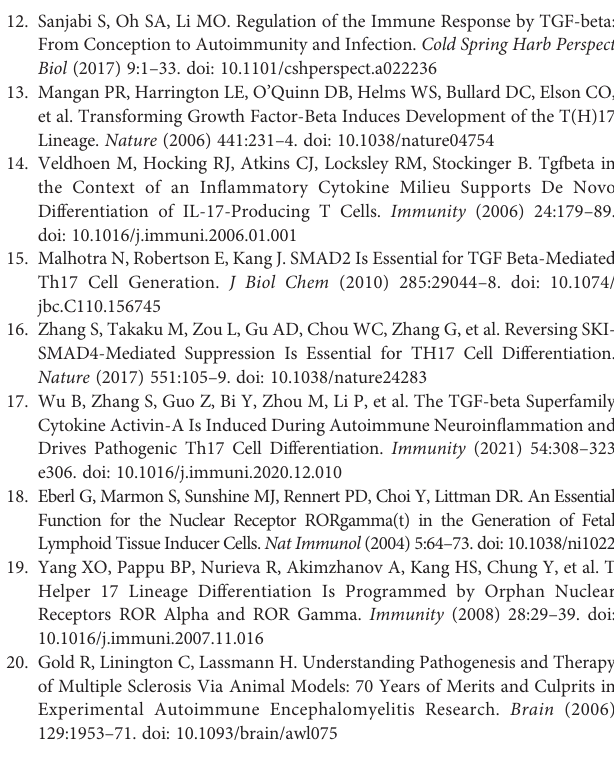
CD3/CD28 plus IL-1 b , IL-6 and IL-23) polarizing conditions for four days. Left, representative plot; right, statistical summary of four replicates; means ± s.d.,